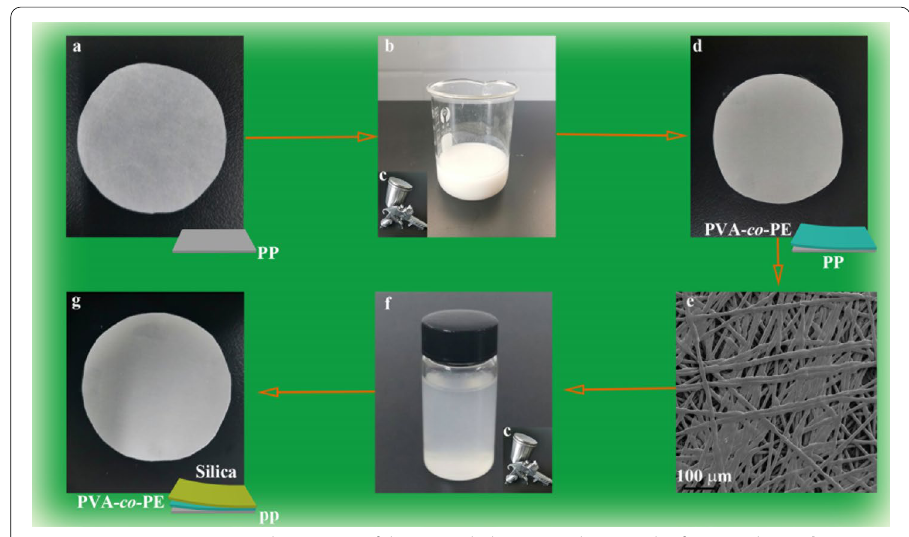
Fig. 1 Preparation process and structures of the PM and silica/PM a photograph of PP membrane; b PVA -co- PE nanofiber suspension; c spray gun; d photograph of PM; e SEM image of the surface of PM; f silica suspension and g